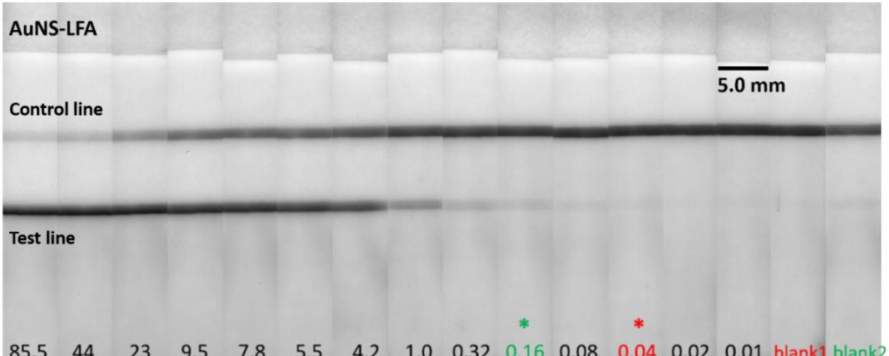
Figure 4. Representative photographs taken from the 150 nm gold-nanoshell-based LFAs with 50 µ L sample volume. LOD of 0.04 µ IU/mL was obtained when compared with blank 1 (DI water) and LOD of 0.16 µ IU/mL was obtained when compared with blank 2 (TSH-depleted serum). The asterisks ( ∗ ) indicate the